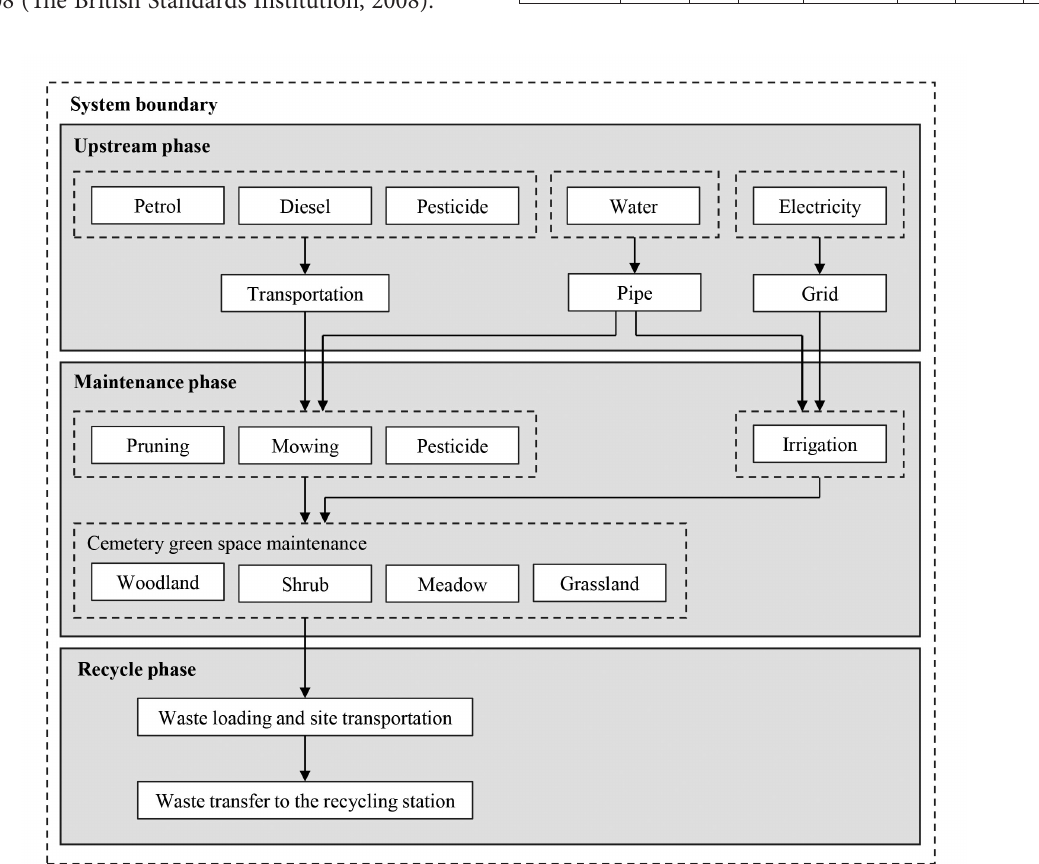
Figure 4. Life cycle flow chart of cemetery green space maintenance (source: Lindholst, 2008; Liu & Yang,